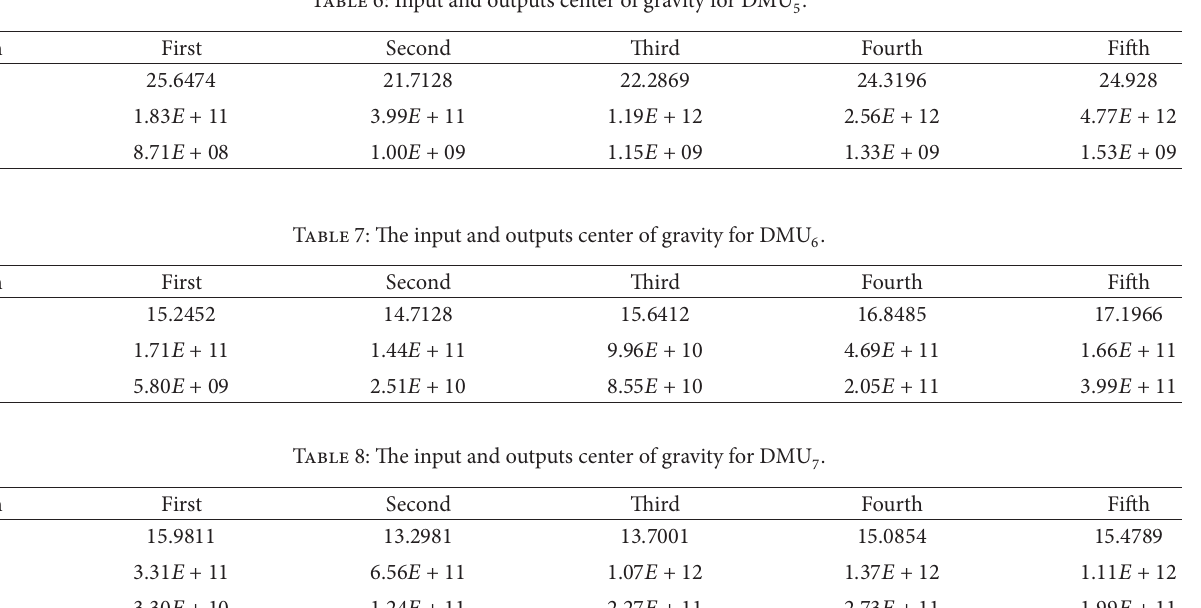
Table 6: Input and outputs center of gravity for DMU 5 .